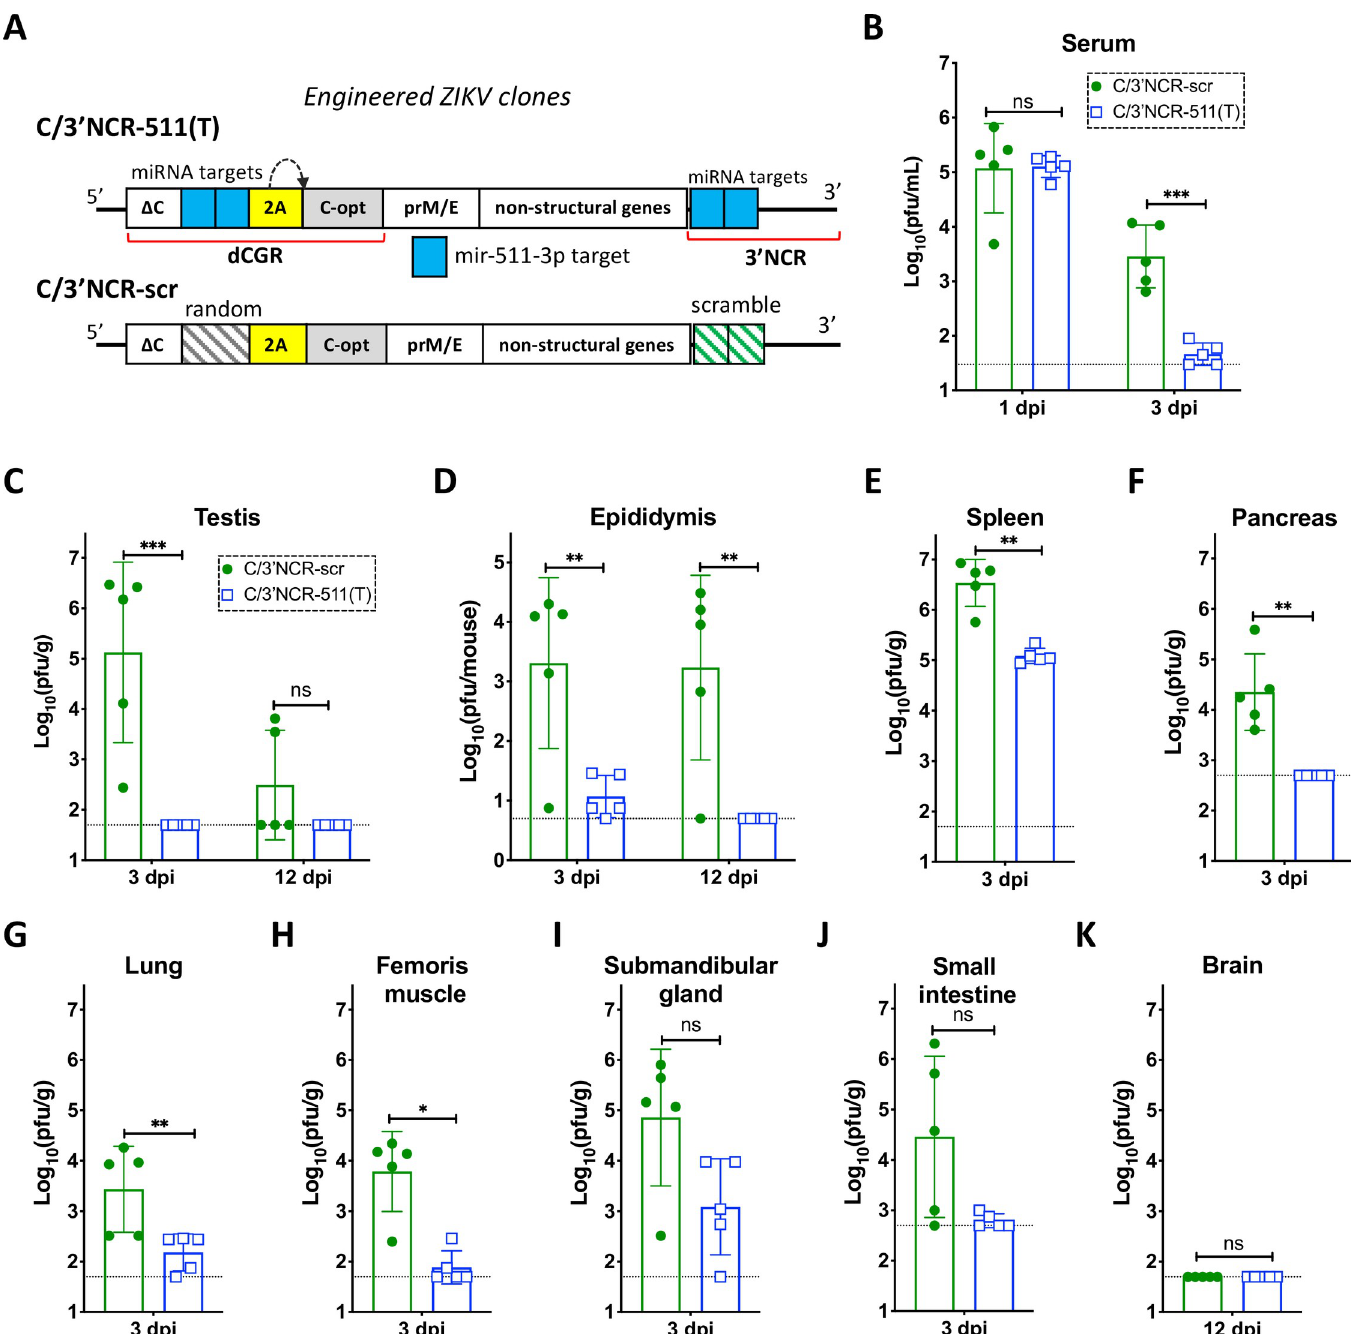
Fig 6. Insertion of multiple copies of mir-511-3p target sequences into distant regions of the ZIKV genome inhibits viral replication in peripheral mouse organs. (A) Schematic representation of viruses used in the mouse studies. ( B-K ) Male AG129 mice (5 per group) were infected IP with 10 6 pfu of C/3’NCR-511(T) or C/3’NCR- scr virus and were bled at 1 dpi and sacrificed at 3 dpi, or were not bled and sacrificed at 12 dpi. ( B) Mean virus titer ± SD in the serum at 1 and 3 dpi. ( C-D ) Mean virus titer ± SD in the testes ( C ) and epididymis ( D ) at 3 dpi and 12 dpi. ( E-K ) Mean virus titer ± SD in the spleen ( E ), pancreas ( F ), lung ( G ), femoris muscle ( H ), submandibular gland ( I ) and small intestine ( J ) at 3 dpi, and in the brain ( K ) at 12 dpi. The dashed lines indicate the limit of virus detection: in the serum [1.5 log 10 pfu/ mL]; in the testes, spleen, lung, femoris muscle, submandibular gland and brain [1.7 log 10 pfu/g of tissue]; in the pancreas and small intestine [2.7 log 10 pfu/g of tissue]; and in the epididymis [0.7 log 10 pfu/mouse]. Differences between viral titers in the serum, testes and epididymis were compared using two-way ANOVA, and differences between viral titers in other organs were compared using two-tailed Mann-Whitney test. ��� p < 0.001; ���� p < 0.0001; ns denotes p > 0.05.